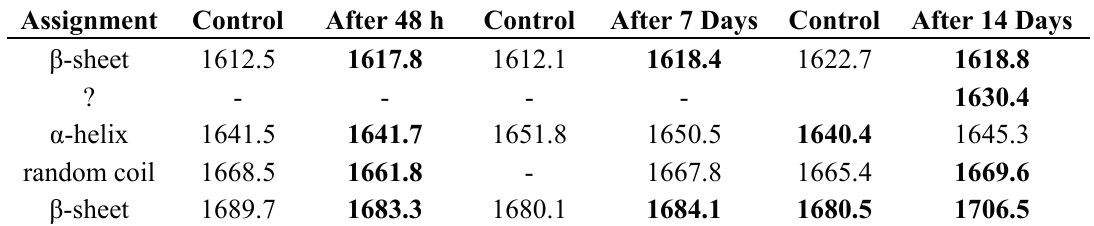
Table 1. Peak centers (in cm − 1 ) of main Raman modes of Amide I region identified by deconvolution of experimental data. Numbers in bold refer to Gaussian functions and normal ones to Lorentzian